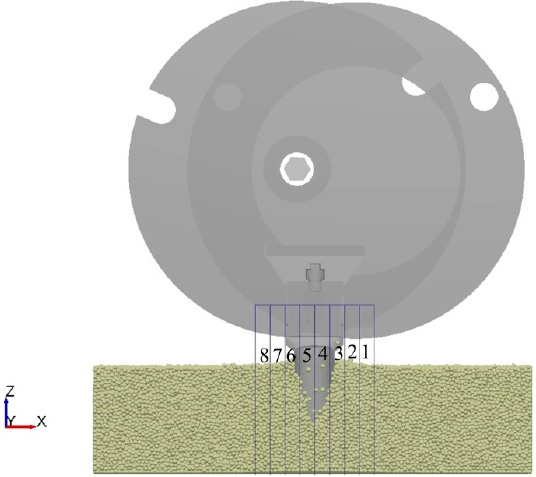
Figure 9. Diagram of the longitudinal monitoring area layout. Notes: 1–8 are various monitoring zones.